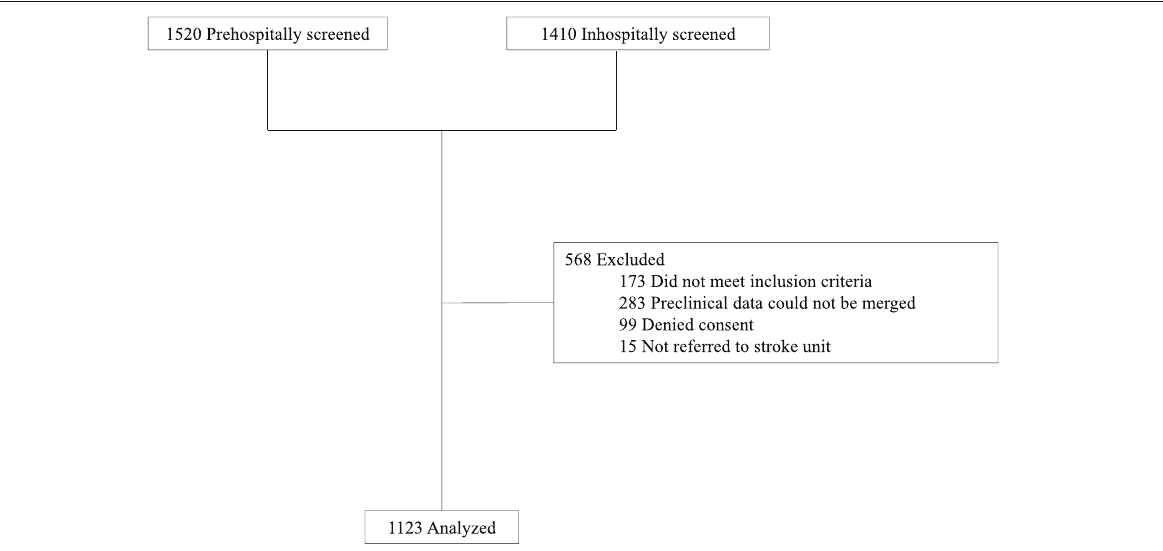
Fig. 1 Strengthening The Reporting of Observational Studies in Epidemiology (STROBE) diagram illustrating the trial design and exclusion of patients from the study. Patients with suspected stroke were enrolled in the hospital after evaluation for inclusion and exclusion criteria and after informed consent had been obtained. For pseudonymization, separated data sets from the prehospital and in-hospital phases of acute stroke management were linked exclusively on the basis of information about the date of stroke, target hospital, sex, and the patient ’ s year of